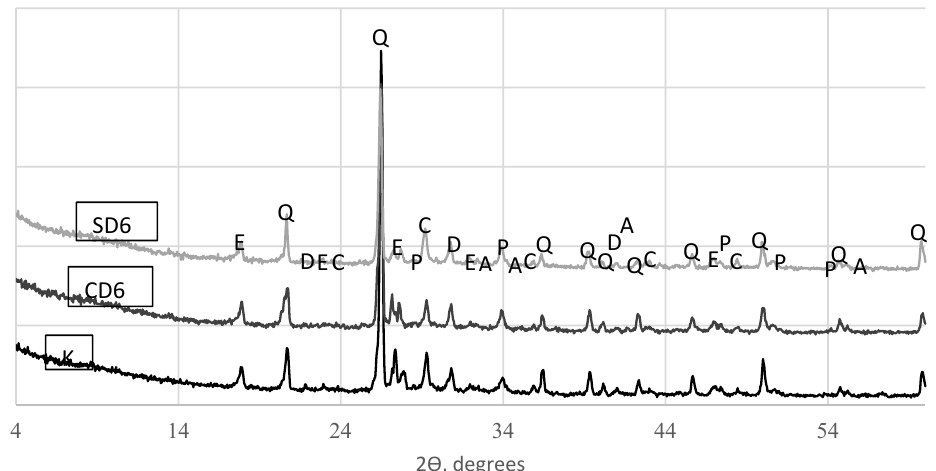
Figure 13. X-ray di ff raction (XRD) patterns (E—ettringite, Q—quartz, D—dolomite, C—calcite, P—portlandite,